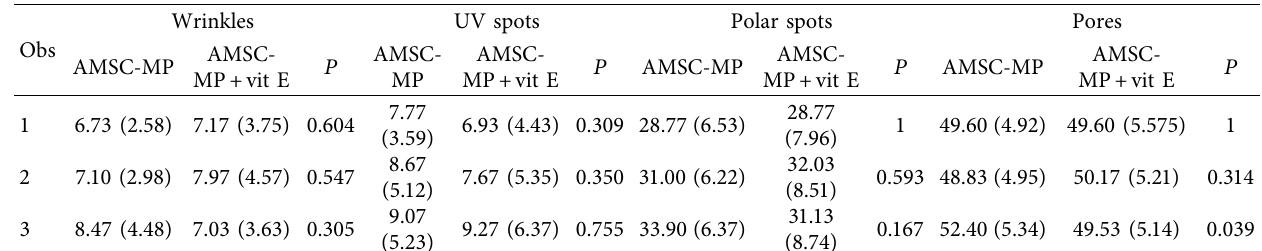
Table 3: A comparison between the control and treatment